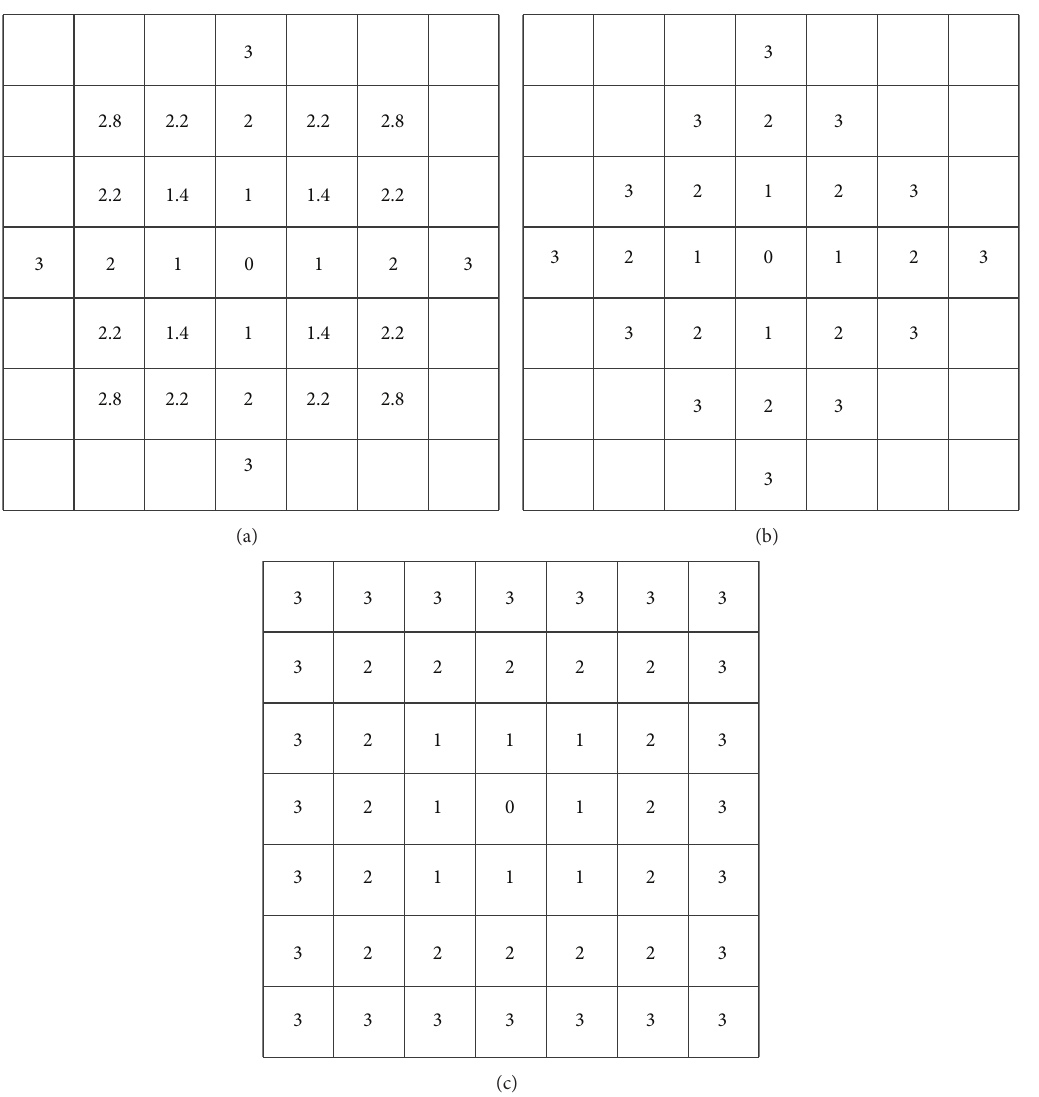
Figure 2: The Euclidean, Manhattan, and Chessboard distance in raster mode. (a) A raster region of 𝑑 𝑒 ≤ 3 , (b) a raster region of 𝑑 𝑚 ≤ 3 , and (c) a raster region of 𝑑 𝑐 ≤ 3